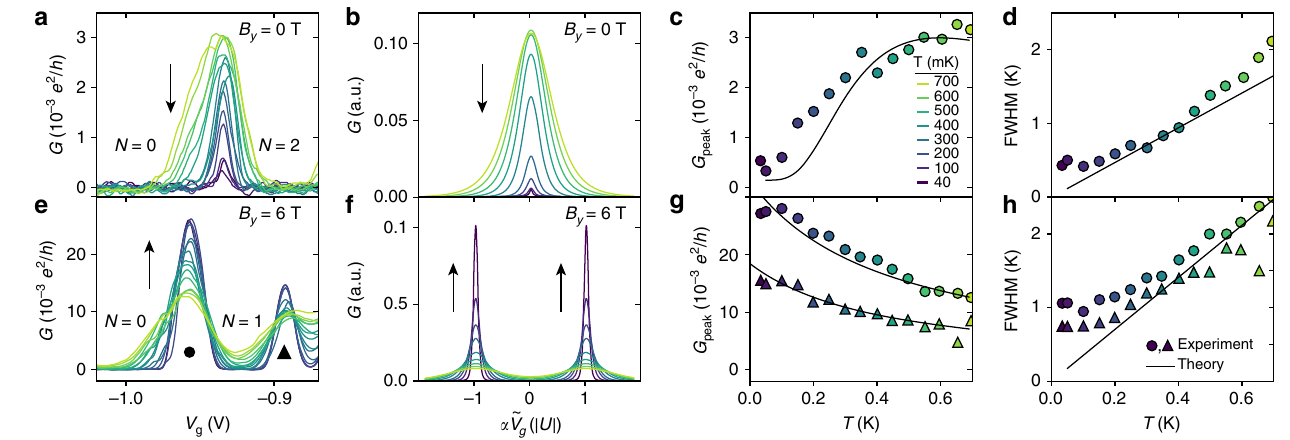
Fig. 3 Temperature dependence of zero-bias conductance. a G ( V g ) for varying temperature T at B y = 0T. N labels the occupation of the orbital, and the color coding of the different temperatures relevant for all panels is shown in c . b Corresponding theory calculations based on the negative- U Anderson model. Arrows indicate the qualitative temperature dependence of the peak conductance. c The temperature dependence of the fi tted conductance peak amplitude G peak and d full width at half maximum (FWHM). The results of the simulations are shown as solid lines . e – h Shown are the results corresponding to a – d measured with B y = 6T, where transport is dominated by conventional sequential tunneling. The resonance peak has split into two peaks indicated by markers (cid:129) and respectively, with the corresponding calculations presented in Fig. 3b, f (Supplementary Note 5). The extracted peak heights and widths for the two cases are presented in Fig. 3c, d, g, h. The measurements allow a direct comparison of the negative- U situation ( B y = 0) and the sequential tunneling case ( B y = 6 T). Considering fi rst the peak heights, it is clear from Fig. 3a – d that two opposite trends are observed. For B y = 6 T, the peak height increases with decreasing T as ∝ 1/ T , as expected for sequential tunneling in the limit (cid:4) Δ E ; E Γ (cid:4) k 36 . The result is consistent with our calcula- B T C tions and con fi rms the discrete spectrum of the QD. For the B = 0